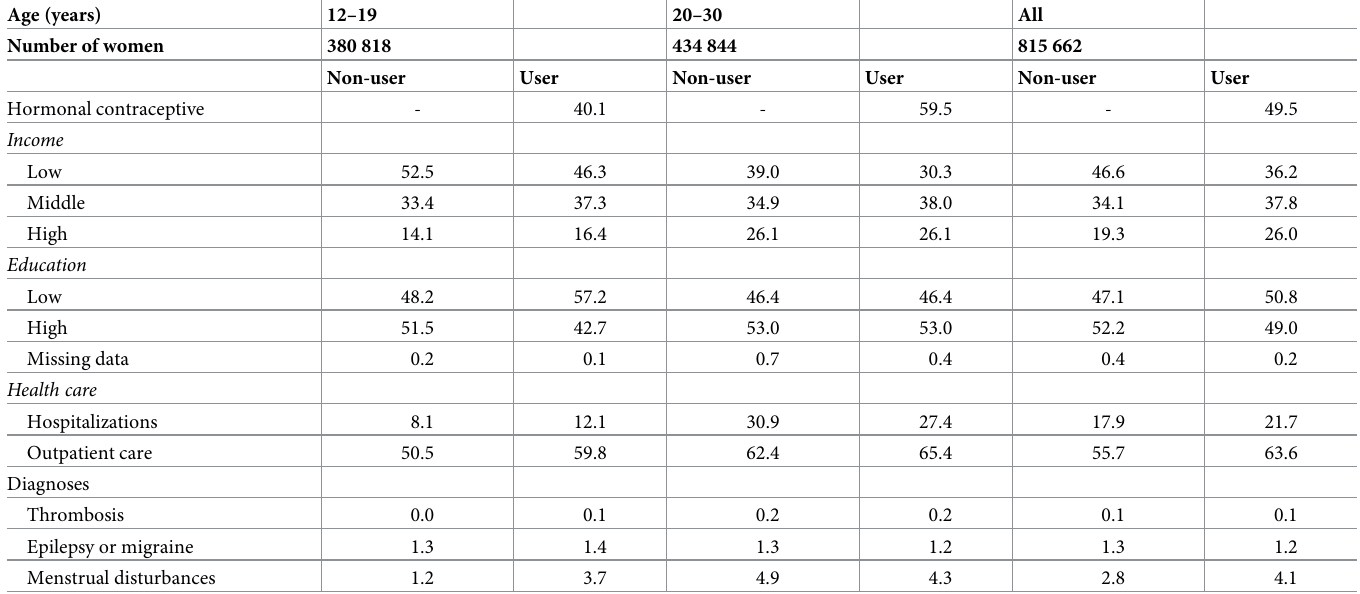
Table 1. Prevalence of different hormonal contraceptive methods in our cohort. Use of hormonal contraception, socioeconomic characteristics, contact with health care, and previous diagnoses at baseline (2010–2011) by age groups and use of hormonal contraceptives in our cohort of 815 662 Swedish women. Values are percentages, unless otherwise